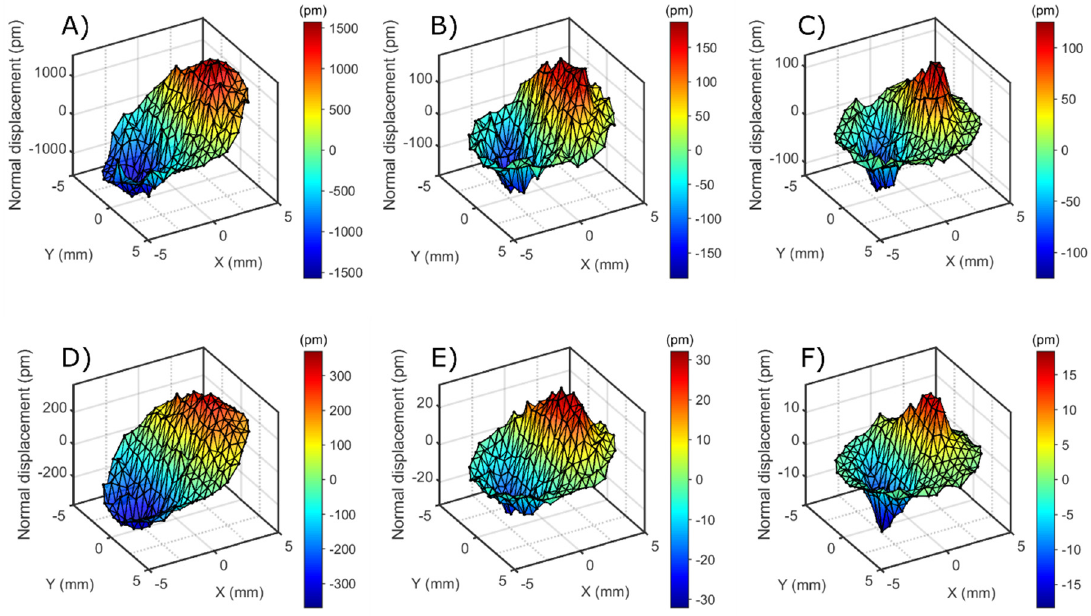
Figure 3. Operating deflection shape in normal direction (diameter of plate: 14 mm). ( A )–( C ): in air. ( D )–( F ): rear side in contact with water; Frequencies: (A),(D): 5 MHz, (B),(E): 15 MHz, (C),(F): 25 MHz.